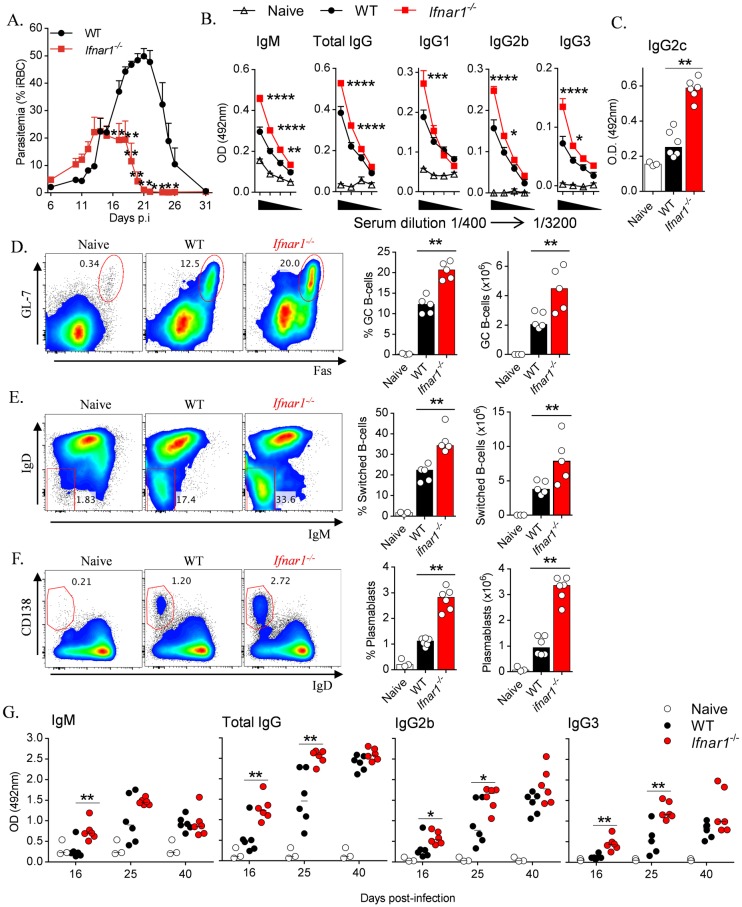
IFNAR1-signalling obstructs B-cell and parasite-specific antibody responses during blood-stage infection.(A) Time-course analysis of parasitemia in WT and Ifnar1
-/-mice (n = 5/group) infected with Py17XNL. (B) ELISA quantitation of Py17XNL-specific IgM, total IgG, IgG1, IgG2b, IgG3 in serum diluted from 1 in 400 in two-fold sequential dilutions to 1 in 3200, and (C) IgG2c at 1 in 400 in the sera of naïve and infected WT and Ifnar1
-/- mice, 16 days p.i. (D&E) Representative FACS plots (gated on B220+ CD19+ live singlets), proportions and absolute numbers of (D) splenic GC B-cells (GL7+ Fas+) and (E) Ig-class-switched B-cells (IgDlo IgMlo) in naïve and infected WT and Ifnar1
-/- mice, 16 days p.i. (F) Representative FACS plots (gated on B220+ CD19+ live singlets), proportions and absolute numbers of splenic plasmablasts (IgDloCD138hi) in naïve and infected WT and Ifnar1
-/- mice (n = 6), 6 days p.i. (G) Time course analysis of IgM, total IgG, IgG2b and IgG3 levels in naïve and infected WT and Ifnar1
-/- mice (n = 6). Statistics: Mann-Whitney U test (A & C-G), Two way ANOVA and Tukey’s test for multiple comparisons in (B), *P<0.05; **P<0.01; ***P<0.001; ****P<0.0001. Data representative of three independent experiments for (A), (D) and (E), two for (B) and (F) and one for (C) and (G).